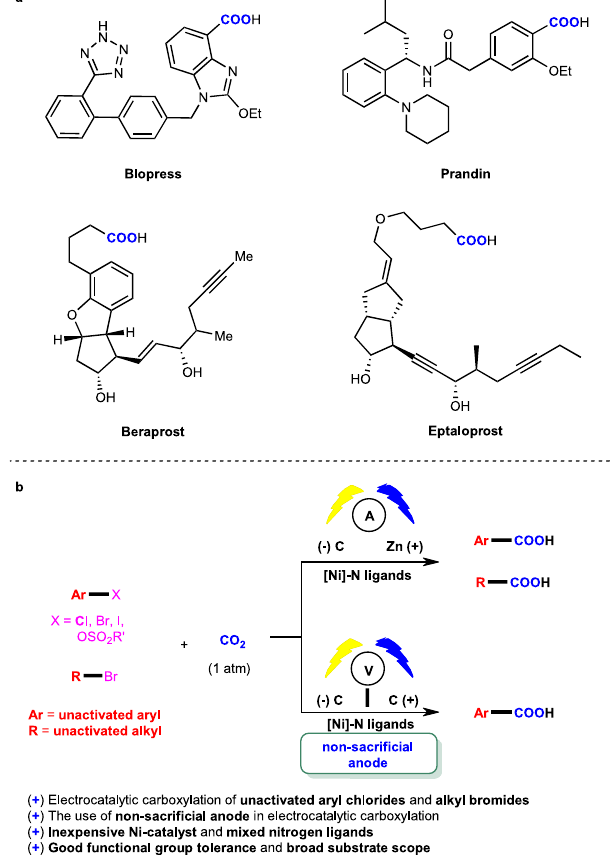
Fig. 1 Background and synopsis of our work. a Selected examples of bioactive compounds containing carboxylic acid moiety. b A general electrocatalytic carboxylation of unactivated organo (pseudo)halides with CO 2